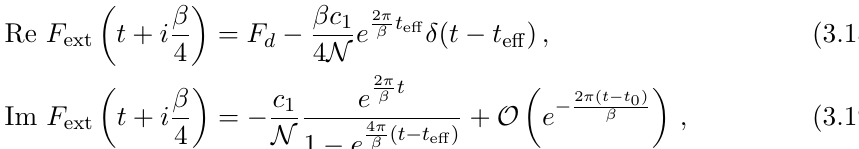
4 . These singularities can be removed by a eff ± iβ/